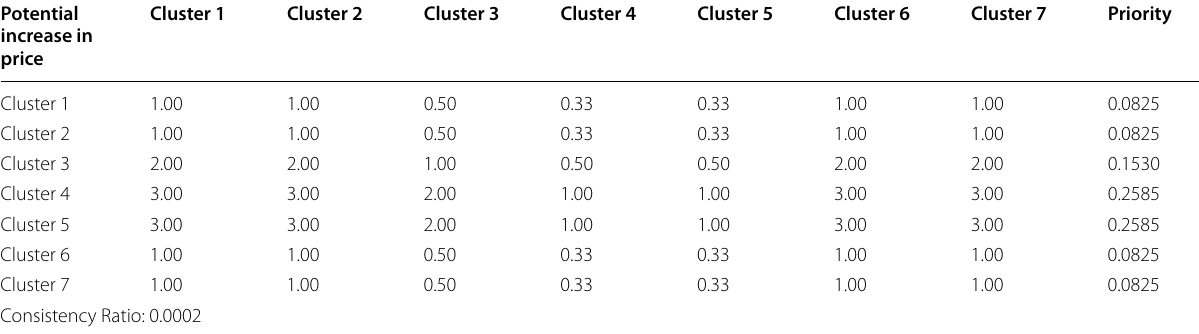
Table 12 Pair Wise Comparison Matrix of Alternatives with respect to the Potential increase in property